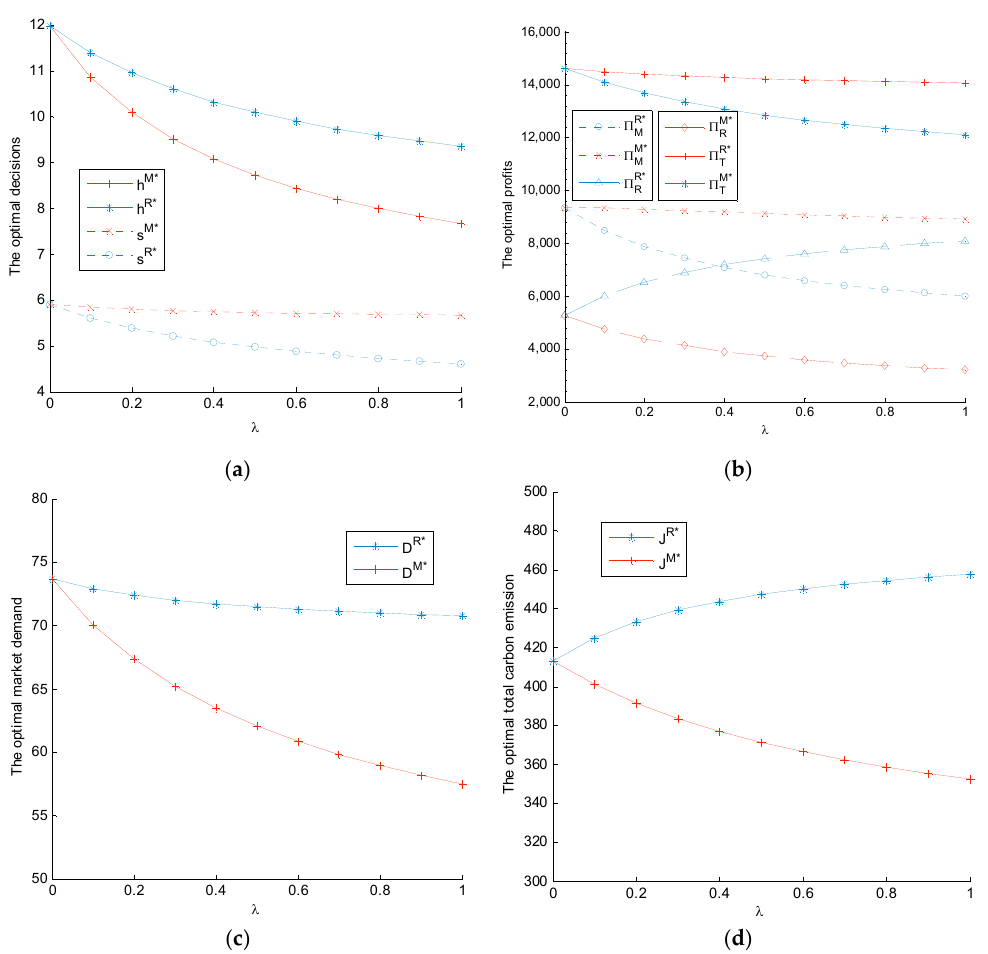
Figure 1. The effects of fairness concern on equilibrium decisions and profits ( m = 1 and θ = 6): ( a ) the optimal sustainability and low-carbon promotion level; ( b ) the optimal profits of the manufacturer, retailer, and supply chain system; ( c ) the optimal market demand; and ( d ) the optimal total carbon emissions.